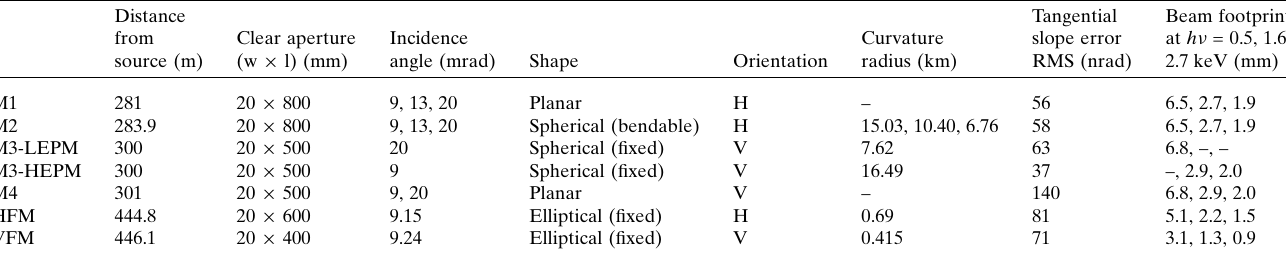
Table 2 Parameters describing the beamline mirrors. Beam footprints, given as FWHM, on the mirrors are not necessarily round; the given values are to be intended for the respective orientation ( e.g. for HFM the beam given footprint is horizontal). Slope error values [root mean square (RMS)] for the tunnel mirrors are from Gerasimova et al. (2022). Distance